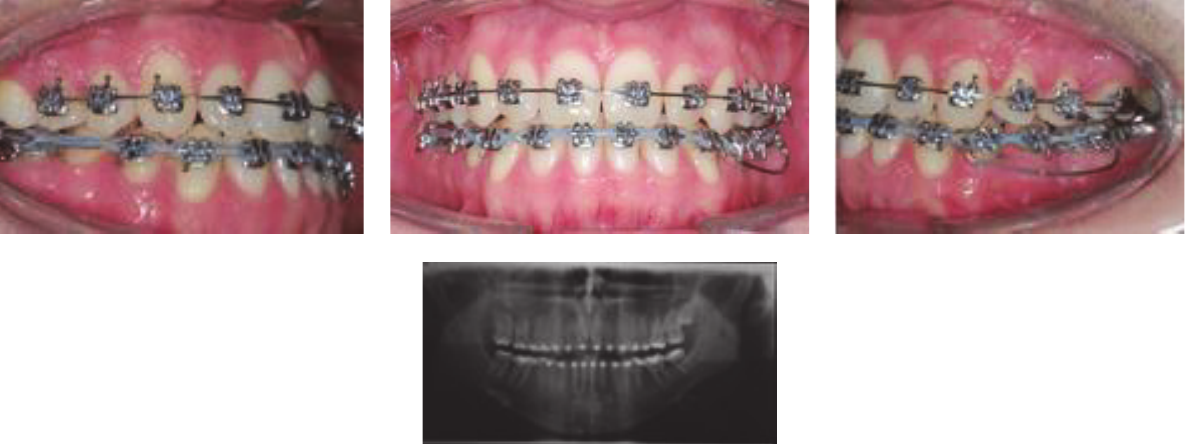
Figure 6: Intraoral views of treatment and panoramic radiograph. Bonding tooth 38, cantilever applied to upright tooth 37, and elastic chain to close the remaining spaces. Panoramic radiograph showing uprighted good position of tooth